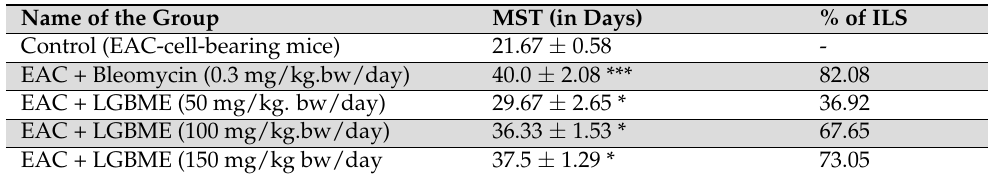
Table 4. Effect of LGBME on MST and %ILS on EAC-cell-bearing